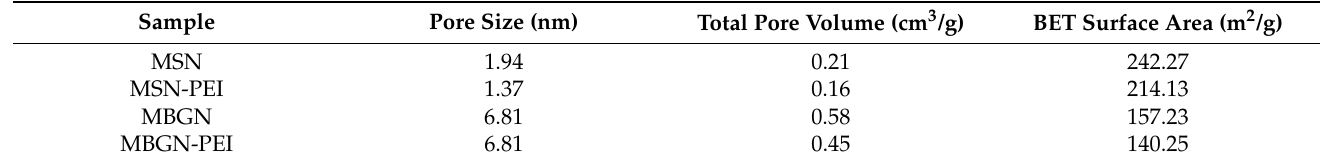
Figure 1. Characterization of MSN-PEI (panels A , B , E , F , I ) and MBGN-PEI (panels C , D , G , H , J ). TEM images (panels A , C ), SEM images (panels B , D ), and N2 sorption isotherms of MSN-PEI ( E ) and MBGN-PEI ( G ). Panels ( F , H ) are the pore size distribution curve of MSN-PEI and MBGN-PEI. Panels ( I , J ) show the particle size using dynamic light scattering analysis of MSN-PEI and MBGN-PEI. The Zeta ( ζ ) potential of particles before and after PEI coating is shown in panel ( K ). The Fourier-transform infrared spectroscopy (FTIR) is shown in panel ( L ) PEI (* and ** indicate the presence of new bands after functionalisation). Table 2. Textural properties of MSN and MBGN before and after PEI